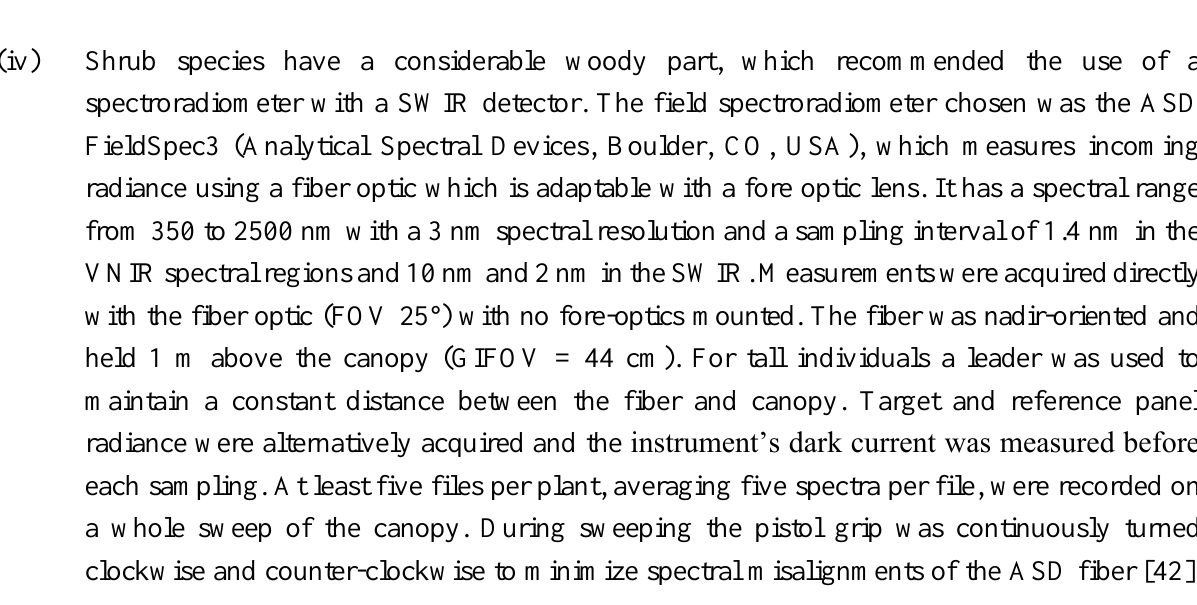
Figure 3. Site location for plant spectral library measurements. Yellow tacks identify spectral signatures acquisition sites and red tacks identify spectral signatures and LAI measurements